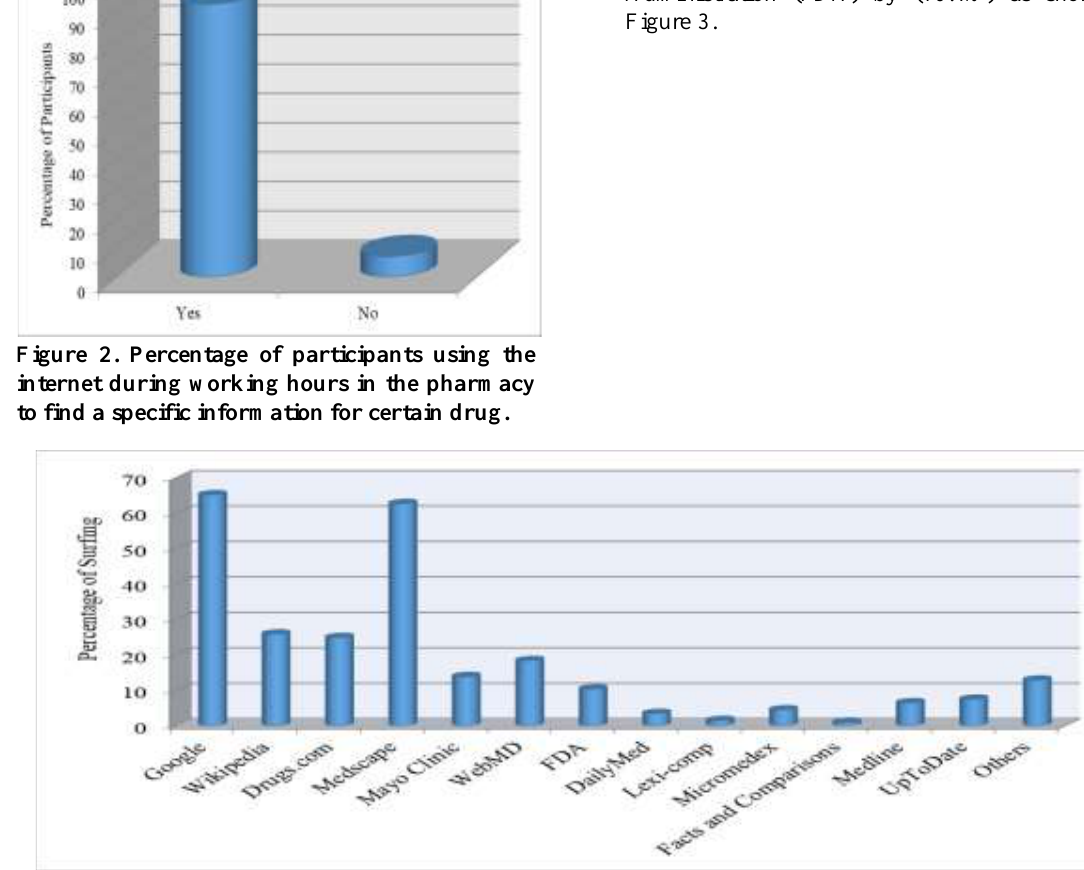
Figure 3. Web sites the participants most commonly surfed to find specific drug information during working in the